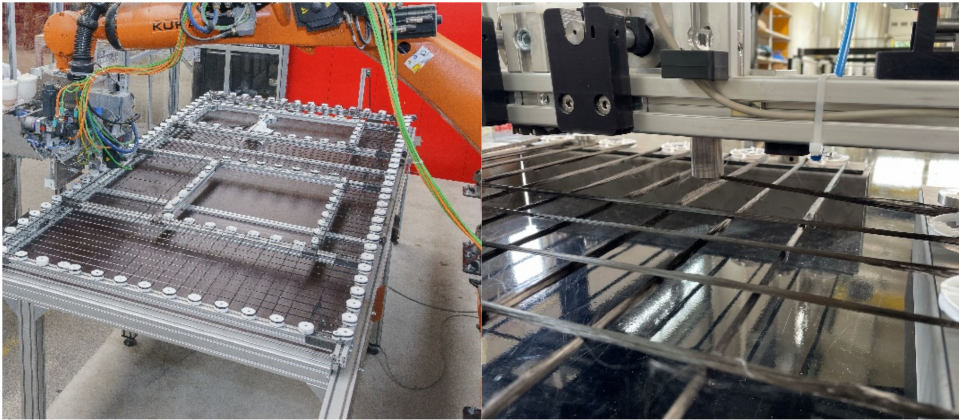
Figure 12. Automated positioning of a freely designed CF textile grid as part of the carbo grid